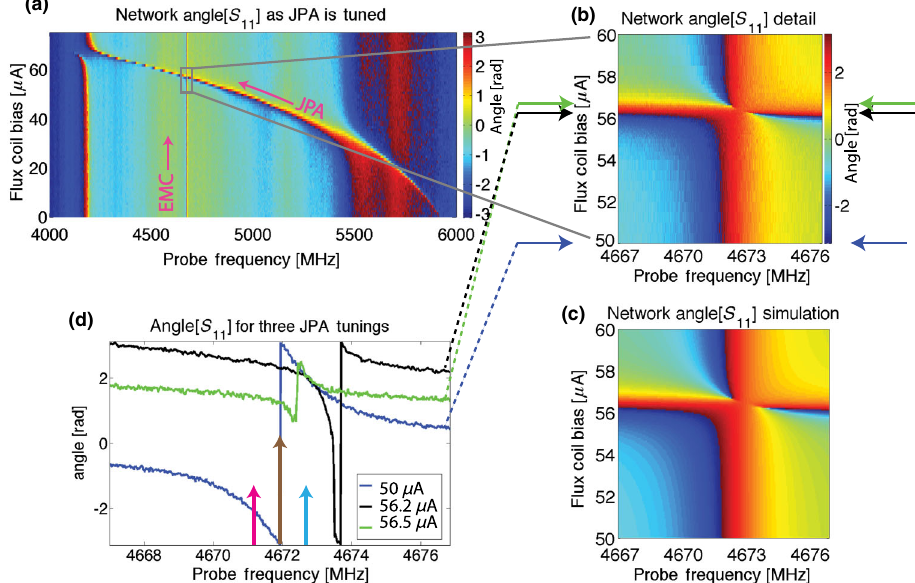
FIG. 2. The network’s microwave response. (a) The network’s 4–6-GHz S phase response to microwave probes as the flux bias is 11 tuned. The JPA resonance shifts with flux and couples to EMC (4.7-GHz) and standing-wave (4.2- and 5.5-GHz) resonances as it passes through them. (b) Detail of the response around the EMC-JPA intersection. (c) Simulation of response detail using a linear control systems model. (d) Phase response line cuts at fixed 50-, 56.2- and 56 : 5 - (cid:3) A flux coil biases, as marked by blue, black, and green arrows in (b). The JPA is far detuned from the EMC at 50 - (cid:3) A coil bias but near detuned for the others. The brown arrow represents an electromechanical coupling tone that is on resonant with the 50 - (cid:3) A -biased network. The blue and red arrows represent (cid:3) 714 - kHz electromechanical sidebands [see Fig.